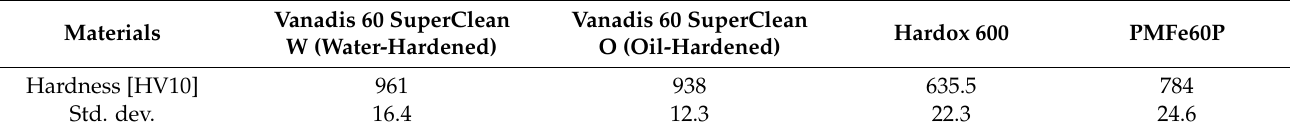
Table 9. Hardness measurement results of tested